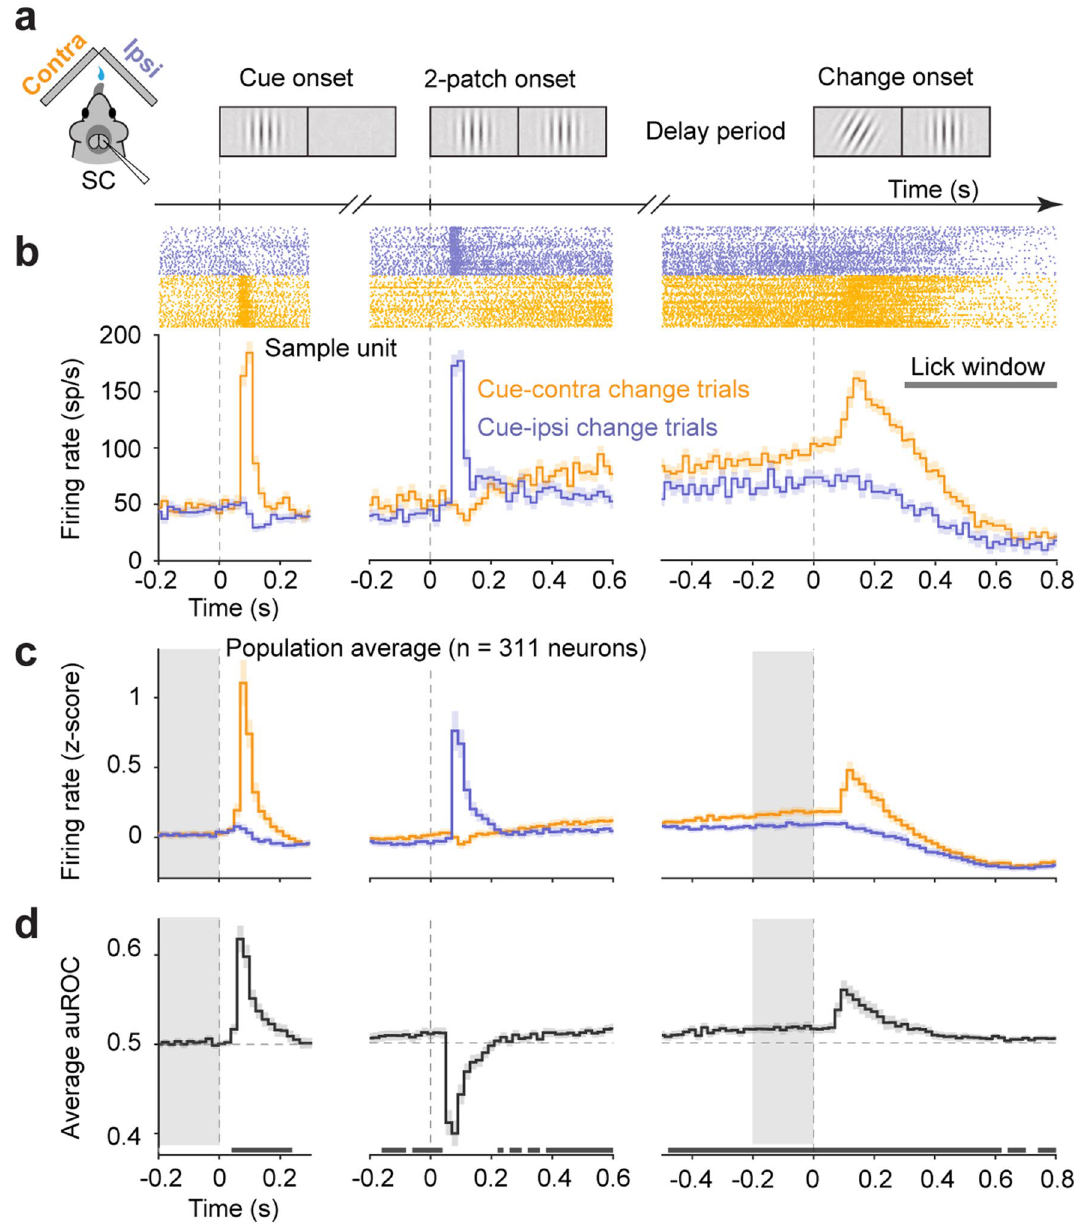
Figure 1. Spatial cue related modulation of mouse SC neuronal activity in a visual change detection task. ( a ) Schematics of unilateral recording in the mouse SC during the “contra/ipsi cue” orientation change detection task, and illustration of visual stimuli on two visual displays in sequences of task epochs: cue, 2 patch and change. Delay period refers to the entire 2-patch epoch. ( b ) Firing rates of a sample SC unit aligned on three task epochs, shown as spike raster (upper) of cue-contra change trials (orange) and cue-ipsi change trials (blue) and Peristimulus time histograms (PSTHs, lower) in 20-ms bins, only trials with hit were plotted. Gray horizontal bar indicates lick window from 300 to 800 ms after orientation change. Shades are error bars, representing 95% confidence interval [CI] of the mean. ( c ) Normalized population PSTHs aligned on the onset of three epochs. Plotting conventions as in ( b ). Gray area in the left panel indicates the 200 ms period precedes the cue-patch onset used to calculate baseline activity; gray area in the right panel indicates the final 200 ms of the 2-patch epoch (defined as the specific analysis “delay period”). ( d ) Time course of population average area under ROC (auROC) comparing spike counts between cue-contra change and cue-ipsi change trials aligned on three task epochs in 20-ms bins. The row of gray boxes below mark bins in which population auROC are significantly > 0.5 chance level ( p < 0.05), as measured in two-tailed Wilcoxon signed-rank tests on population auROC values. The gray area in the left and right panels has the same convention as in ( c